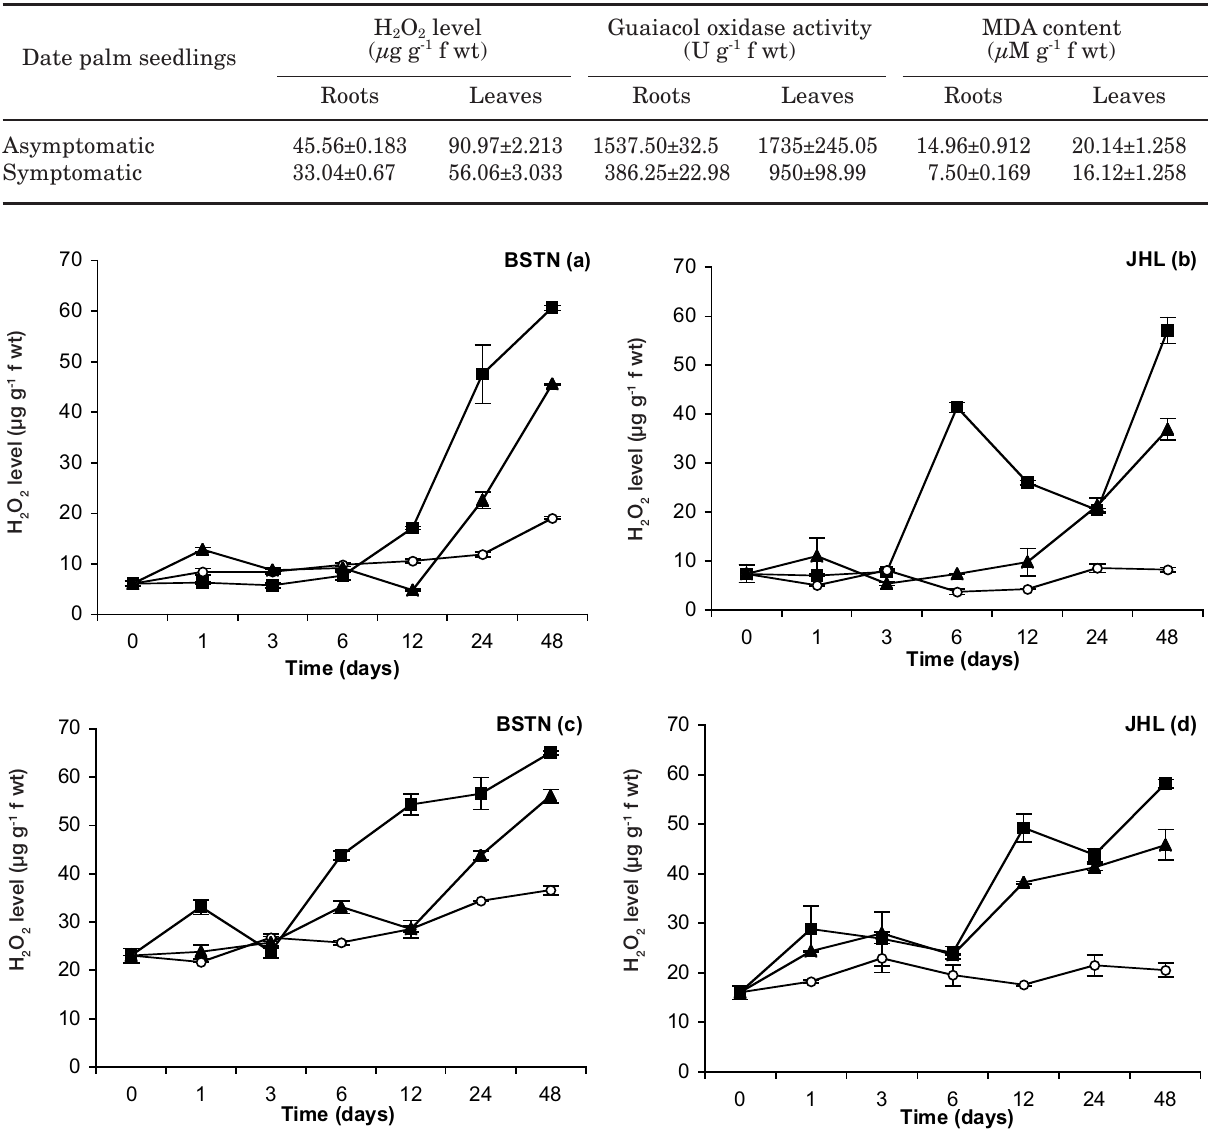
Table 1. Changes in guaiacol oxidase activity and H month after Foa